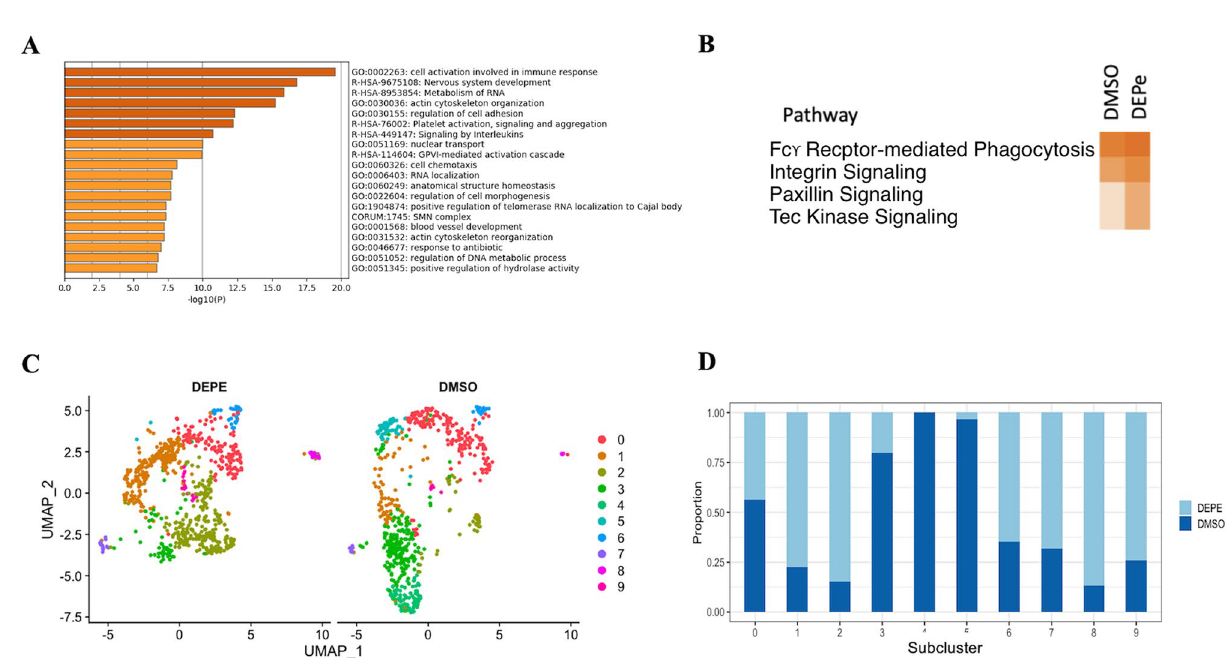
Figure 3. Microglial cluster analysis with and without DEPe exposure. ( A ) The top enriched biological processes for control microglia. ( B ) Ingenuity Pathways Analysis summary. Darker orange denotes more activated pathways (z-score > 2 and p-value < 0.05). ( C ) UMAP plots of DEPe and DMSO treated microglia subclusters. ( D ) Subclustered microglia distribution with DEPe and DMSO